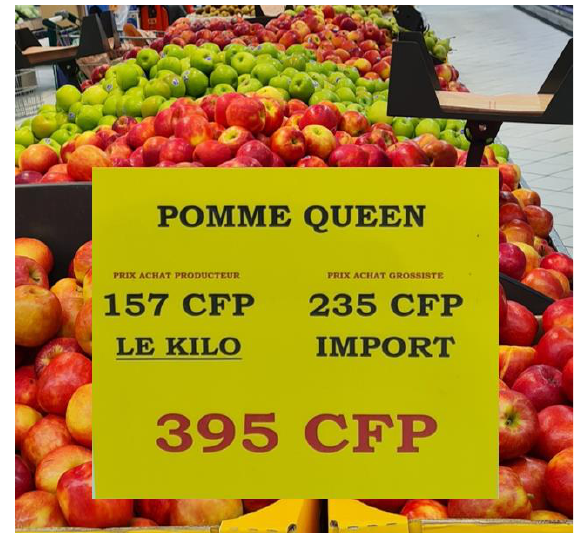
Figure 3. Example of market transparency where the price of the product (apples) is displayed along with the prices paid to the producer and intermediate distributor. Picture from a grocery store in New Caledonia where this transparency measure, along with several market regulation decrees, has been implemented by the agricultural sector since